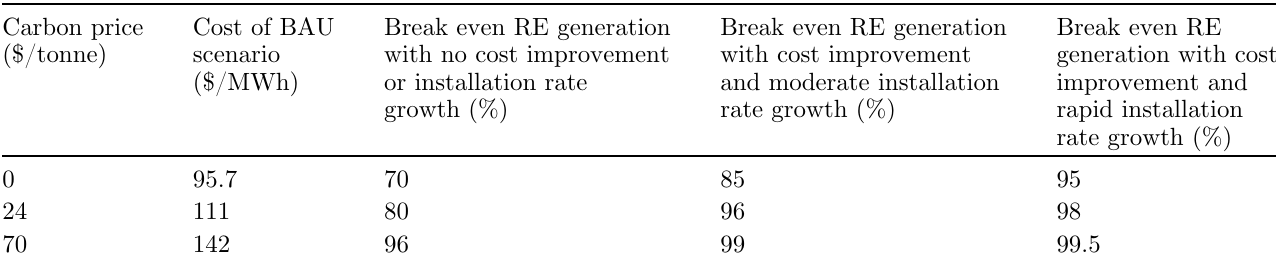
Table 14. Carbon price and level of renewable energy generation for break-even cost with BAU with cost improvement and installation